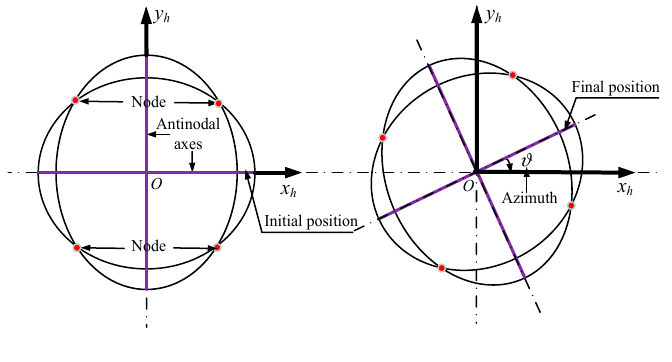
Figure 5. Azimuth of a standing wave.